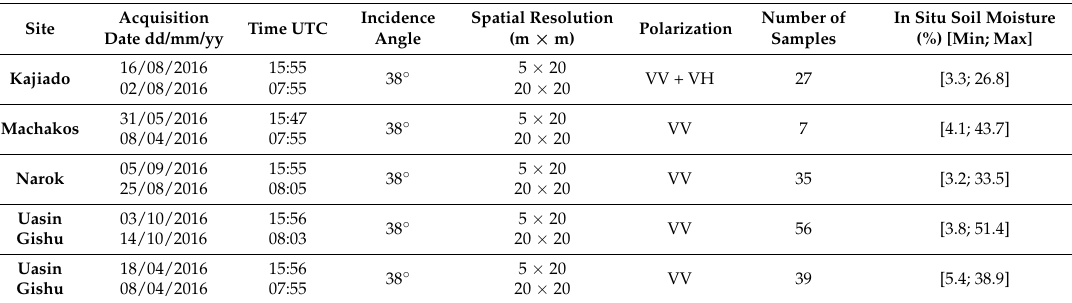
Table 1. Main characteristics of the Sentinel-1 (S-1A), Sentinel-2 (S-2A), and in situ measurements used in this study in cells with two rows: S-1A (upper row), S-2A (lower row).